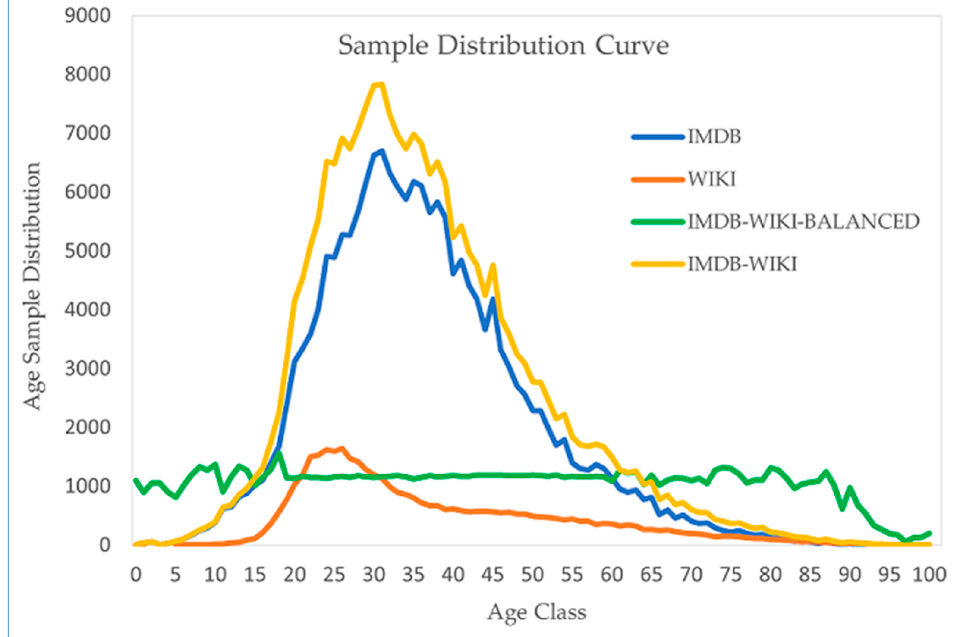
Figure 4. Sample distribution of the revised IMDB-WIKI dataset prior to and following uniformity amongst classes.